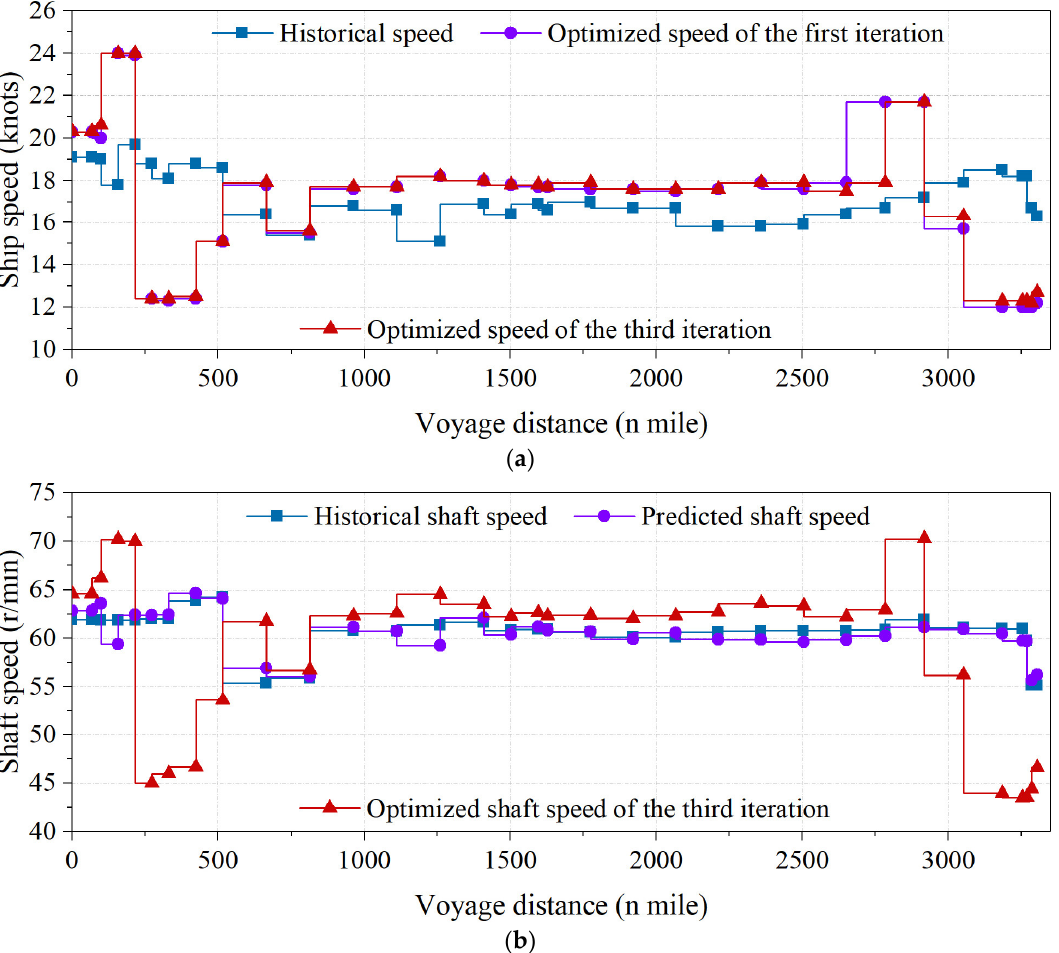
Figure 6. Optimized speed and optimized shaft speed on route 3. ( a ) Ship speed. ( b ) Shaft speed.